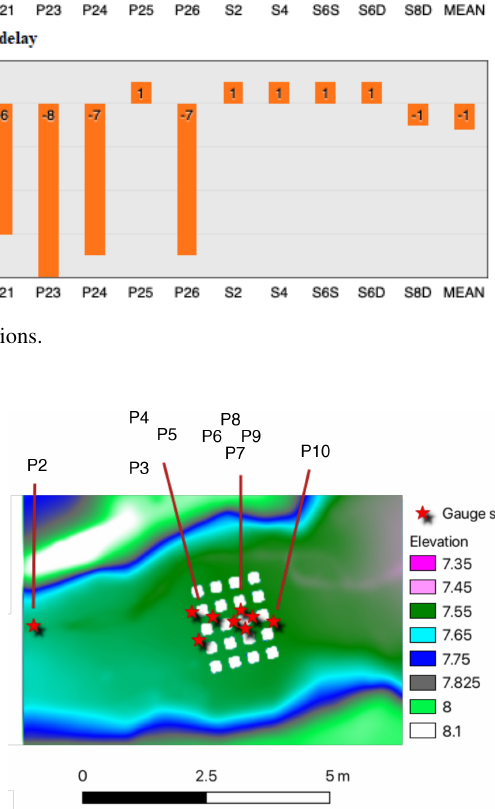
Figure 11. Water depth for experiment and b-flood for gauge sta- tions P2, P10, and P24. Figure 12. Zoom on the first 10m of the topography of the urban model with positions of buildings and gauge